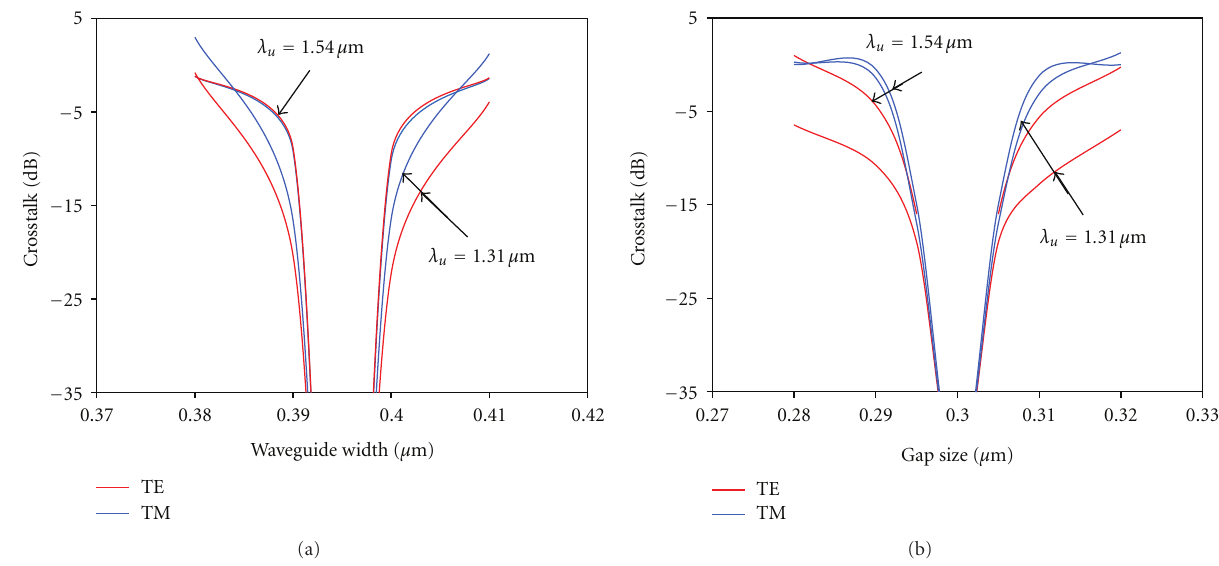
Figure 8: TE and TM crosstalks at the bar port and the cross-port of the CWDM directional coupler for various (a) waveguide widths and (b) gap sizes. All dimensions are in μ